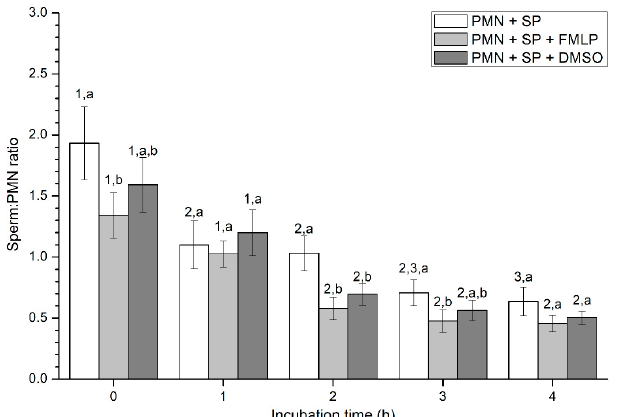
Figure 3. Number of spermatozoa bound to PMN (sperm:PMN ratio) in the three treatments (PMN+SP, PMN+SP+FMLP and PMN+SP+DMSO) throughout the incubation time (4 h; Experiment 2). Different superscripts ( a, b ) mean significant ( p < 0.05) differences between treatments within a given time point, and different numbers ( 1, 2 ) mean significant ( p < 0.05) differences between incubation times within a given treatment. Data are shown as mean ± SEM for seven experiments. Sperm concentration: 500 × 10 6 sperm/mL. PMN concentration: 100 × 10 6 PMN/mL. PMN: polymorphonuclear neutrophils; SP: seminal plasma; DMSO: dimethyl sulfoxide; FMLP: formyl- methionyl-leucyl-phenylalanine.